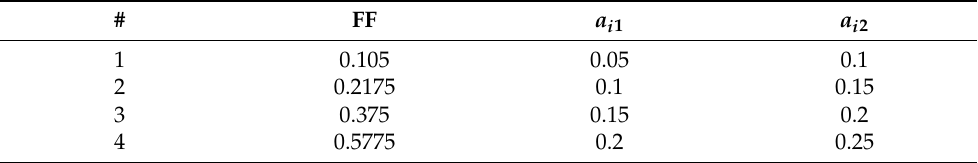
Table 3. The dimensions of the phononic crystals with 9 gradient square inclusions.